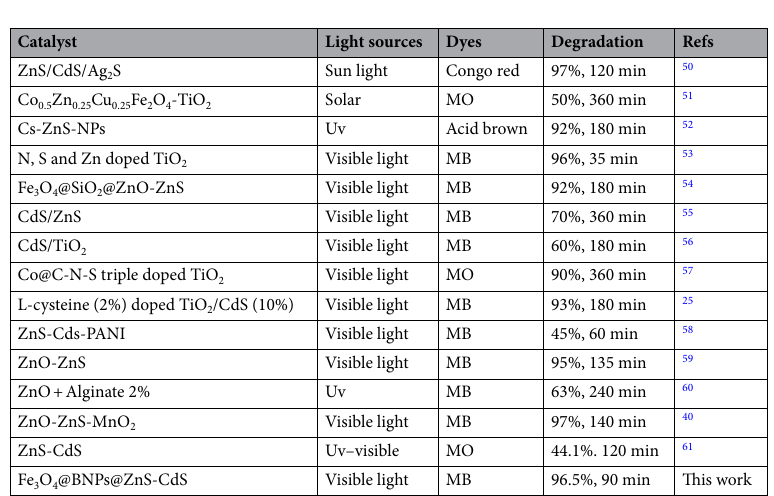
Table 4. Compration of photocatalytic performance of Fe 3 O 4 @BNPs@ZnS-CdS with some photocatalytic systems.